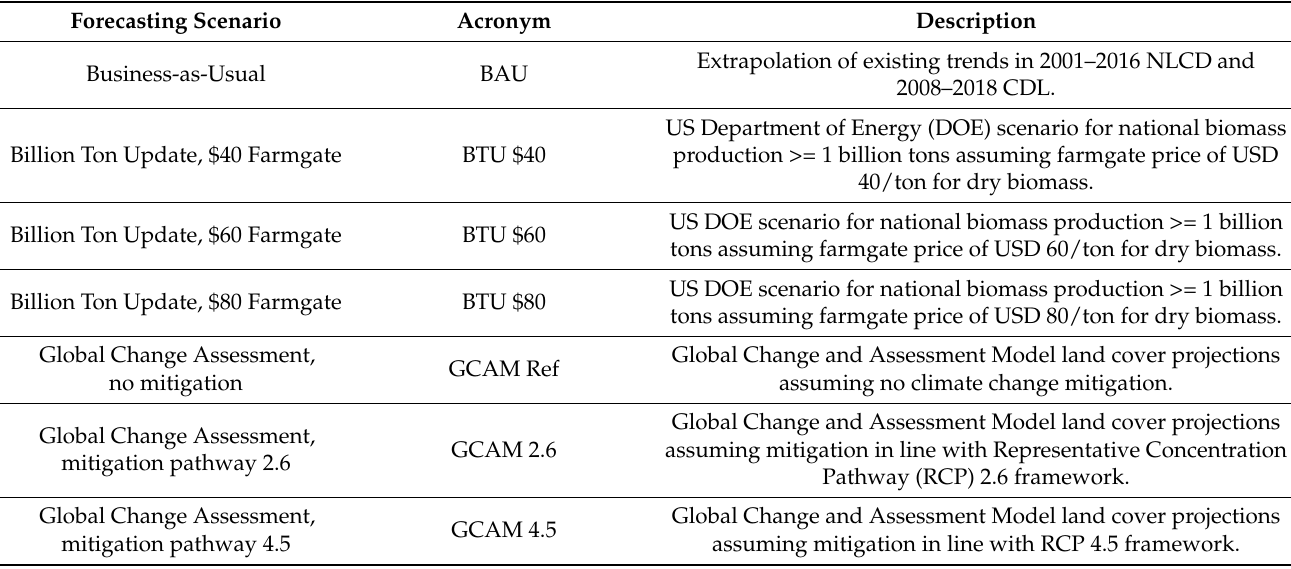
Table 2. Forecasting scenarios developed for the